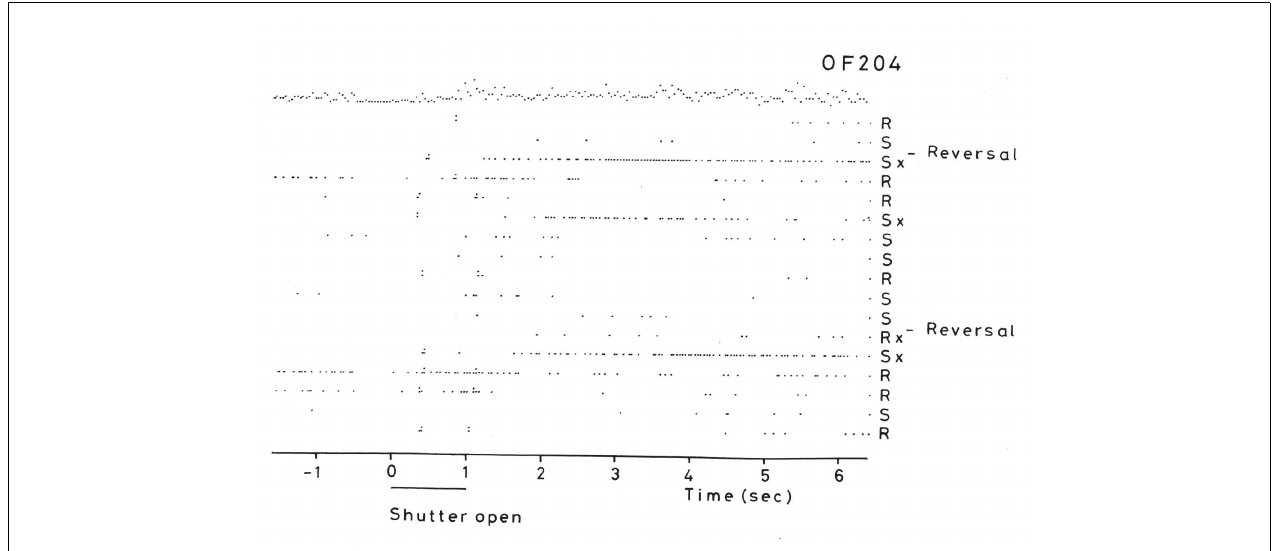
respond on most reward (R) or saline (S) trials, but did respond on the trials marked x, which were the first trials after a reversal of the visual discrimination on which the monkey licked to obtain reward, but actually obtained saline because the task had been reversed. It is notable that after an expected reward was not obtained due to a reversal contingency being applied, on the very next trial the macaque selected the previously non-rewarded stimulus.This shows that rapid reversal can be performed by a non-associative process, and must be rule-based. (AfterThorpe et al.,